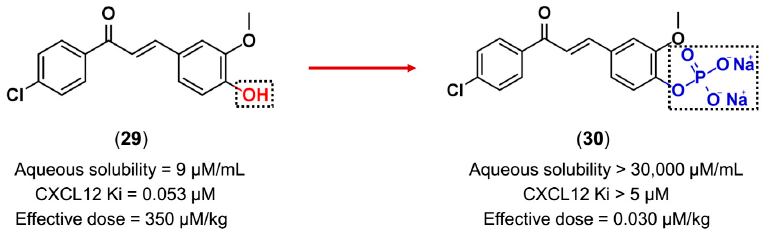
Figure 10. Latentiation represented by the replacing the hydroxyl (red) with a phosphate (blue) [77]. Amino acids were also used to improve the physicochemical properties of chalcone derivatives.